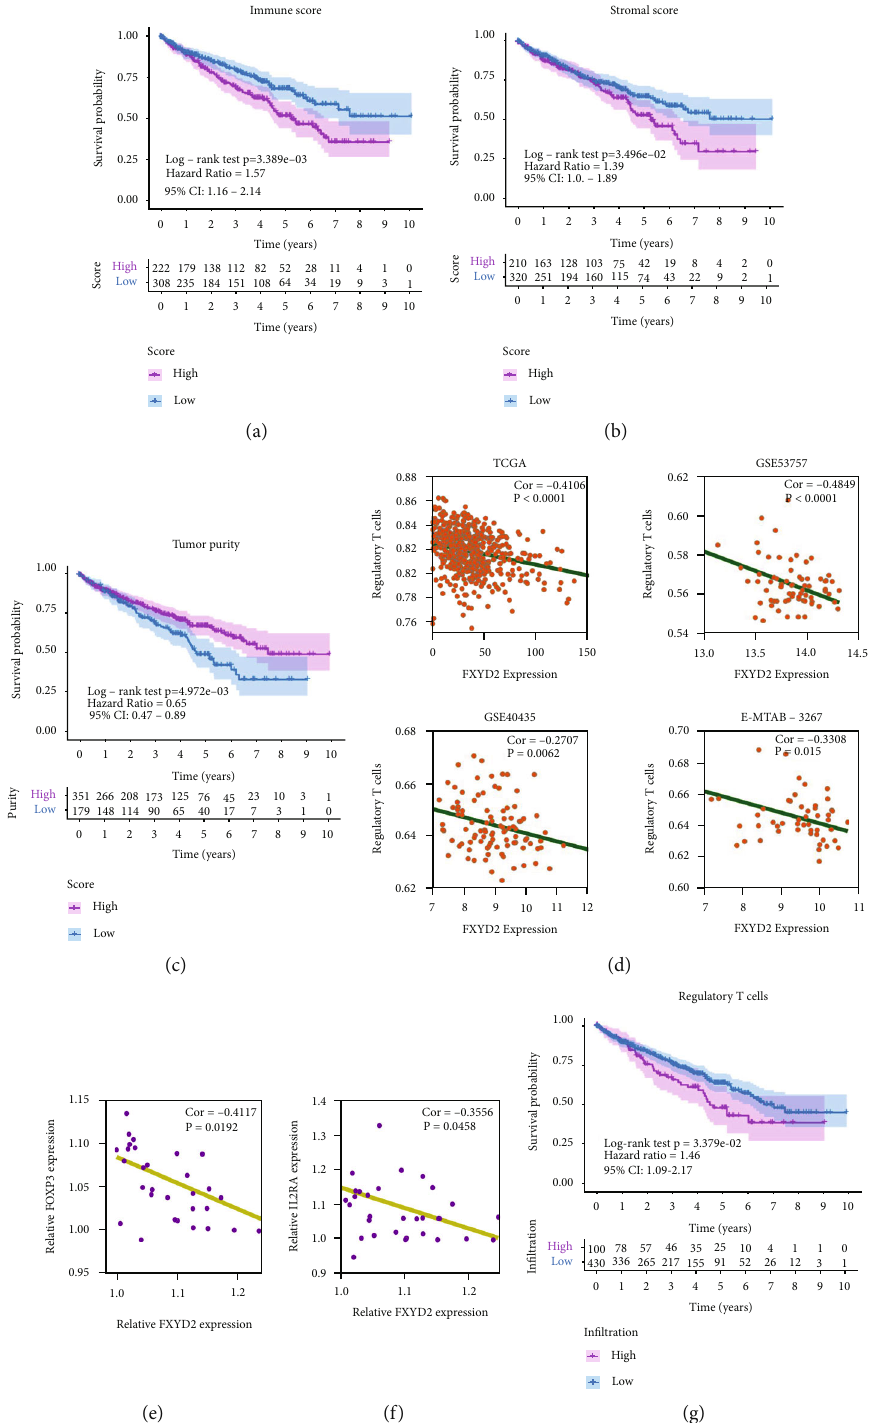
Figure 5: Kaplan-Meier survival analysis of ccRCC patients concerning di ff erent immune factors in the TCGA cohort. (a – c) Patients with high immune score and stromal score and low tumor purity in ccRCC had short-term overall survival. (d) FXYD2 expression negatively correlated with regulatory T cell in fi ltration in TCGA, E-MTAB-3267, GSE53757, and GSE40435 cohort, respectively. (e – f) Relative FXYD2 expression negatively correlated with relative Foxp3 and IL2RA expression using qPCR experiment. (g) Patients with high regulatory T cell in fi ltration in ccRCC had short-term overall